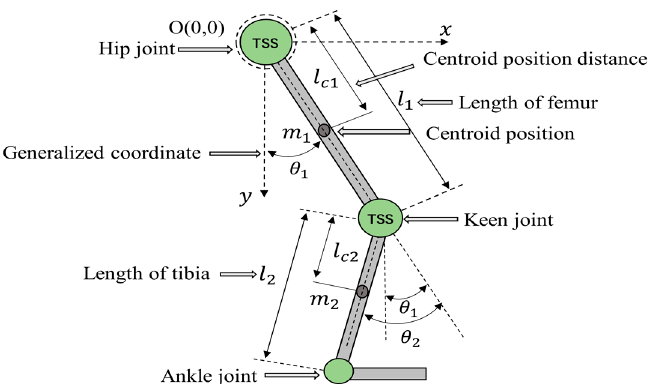
Figure 1. The simplified mechanic structure schematic of CLLE consists of two active DOFs and one passive DOF in each leg. The hip joint drives the thigh, the knee joint drives the shank, and the ankle joint is passively driven by the foot for rehabilitation training. Where l 1 and l c 1 are the length of thigh and the distance of centroid position from knee joint, l 2 and l c 2 are the length of shank and the distance of centroid position from knee joint. m 1 and m 2 are the mass of thigh linkage and shank linkage, θ 1 and θ 2 are the initial angle of